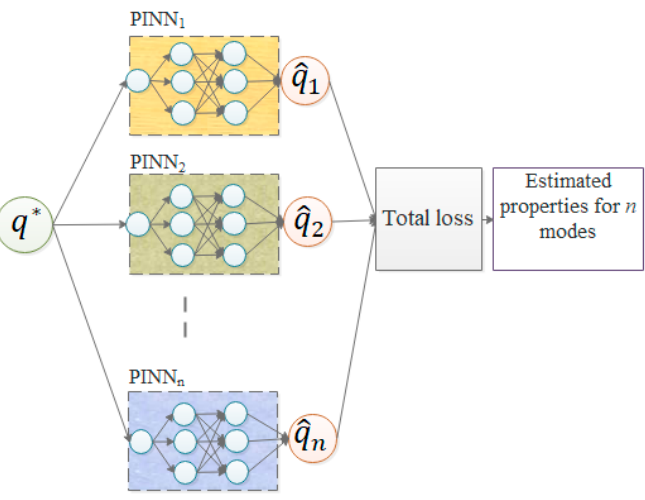
Figure 2. Schematic framework with parallel PINNs.